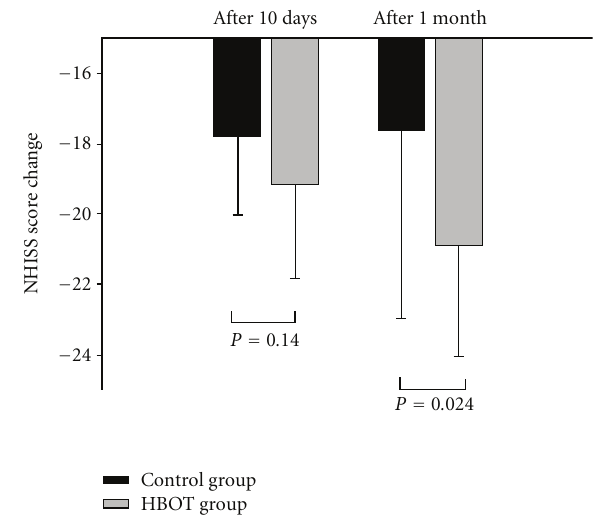
Figure 4: The change of NIHSS scores in both groups. There was no significant NIHSS change on the 10th day after stroke ( P = 0 . 140) but there was significant di ff erence after one month ( P = 0 .